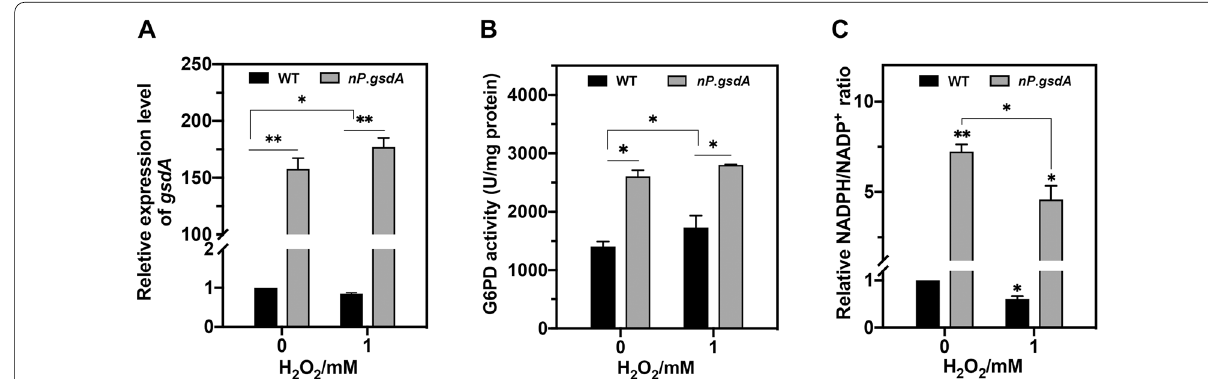
Fig. 2 NO 3 − induction promoted transcription ( A ), activity ( B ), NADPH production ( C ) of G6PD in nP . gsdA strains. A – C Fresh conidia (1 WT (WT_ pyrG ) and nP . gsdA strains were cultivated in MM medium using NO 3 − as the nitrogen source for 16 h and then exposed to the indicated concentrations of H 2 O 2 for 30 min for the following analysis (mean